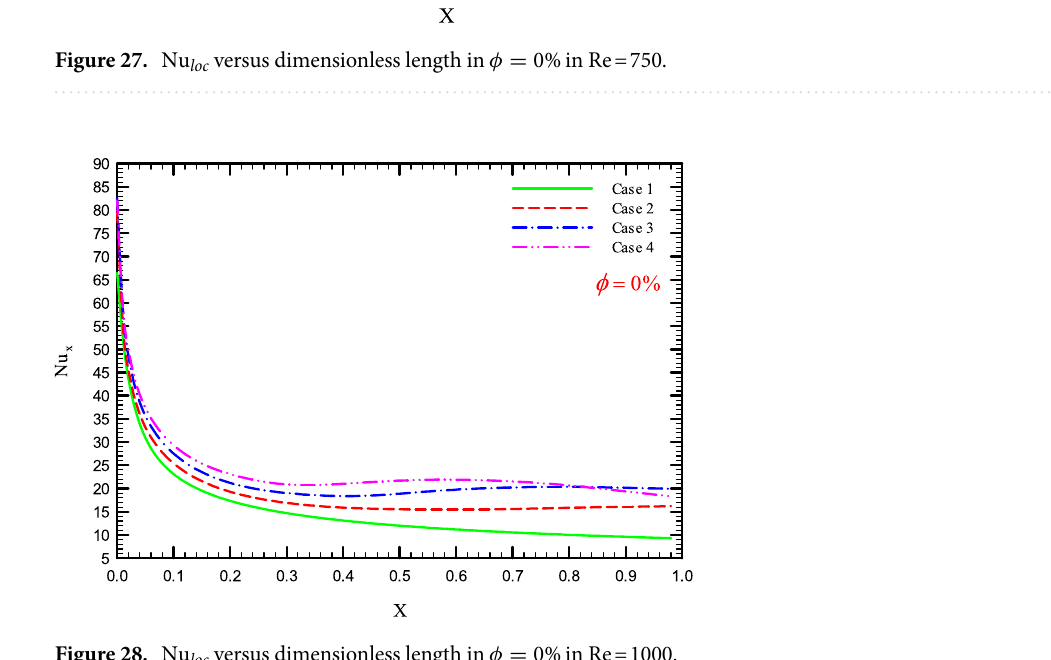
Figure 28. Nu loc versus dimensionless length in φ = 0% in Re =